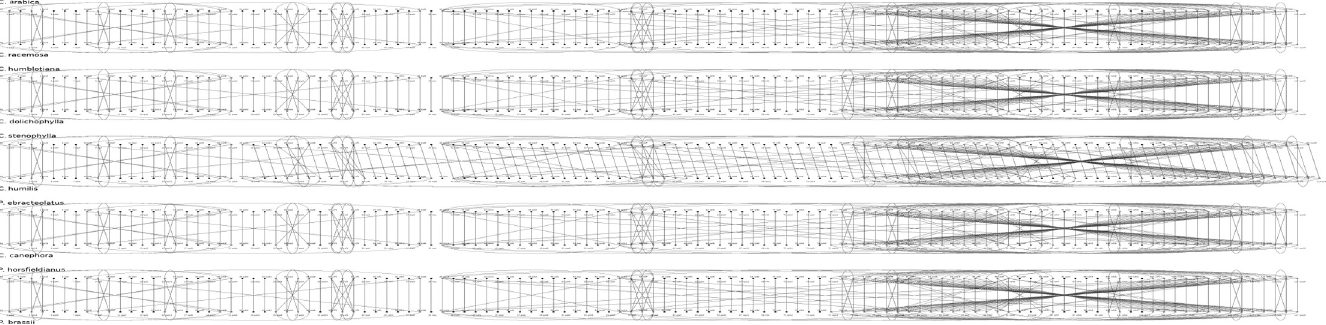
PLOS ONE | https://doi.org/10.1371/journal.pone.0216347 June 12,